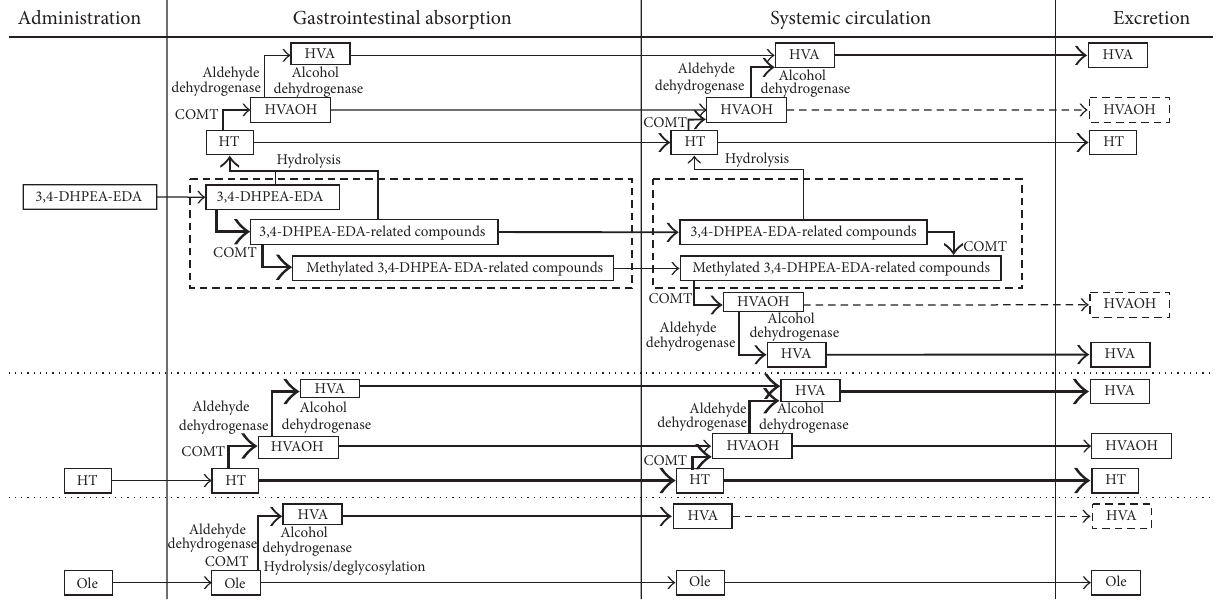
Figure 4: The possible flow of chemical conversion of 3,4-DHPEA-EDA, hydroxytyrosol, and oleuropein after administration in rats. HT: hydroxytyrosol, HVA: homovanillic acid, and HVAOH: homovanillyl